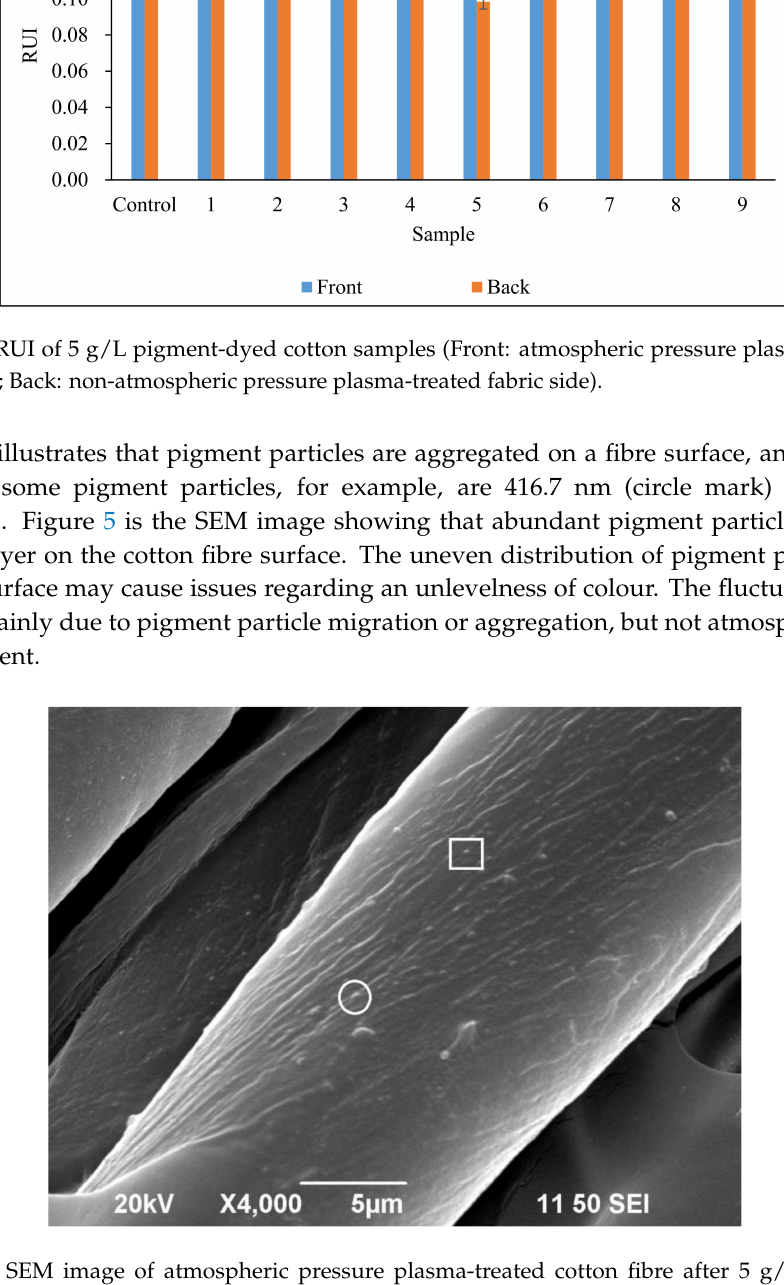
Figure 4. SEM image of atmospheric pressure plasma-treated cotton fibre after 5 g/L pigment dyeing (atmospheric pressure plasma treatment condition: discharge power = 170 W; oxygen flow rate = 0.6 L/min; head moving speed = 1 mm/s; and head-to-substrate distance = 3